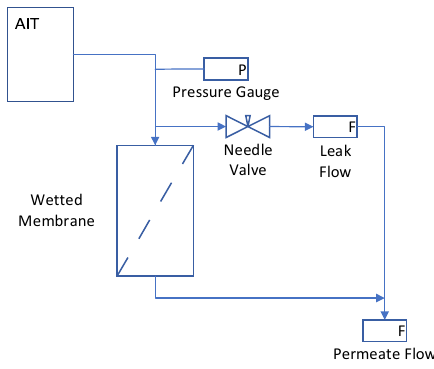
Figure 2. Schematic of controlled leak experimental setup.